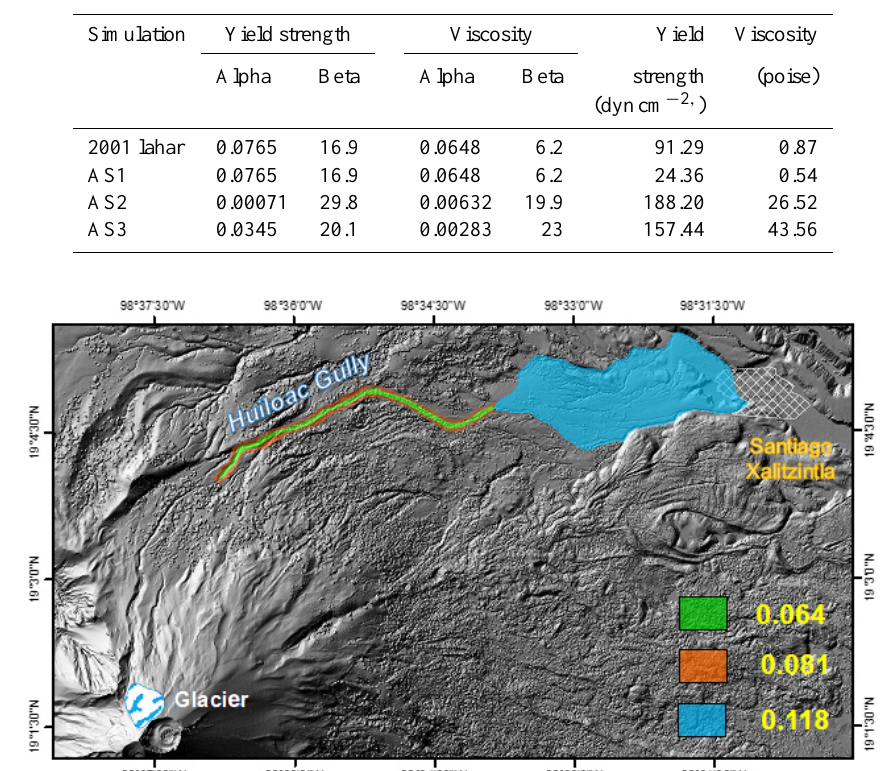
Figure 5. Distribution of Manning coefficients used during FLO2D